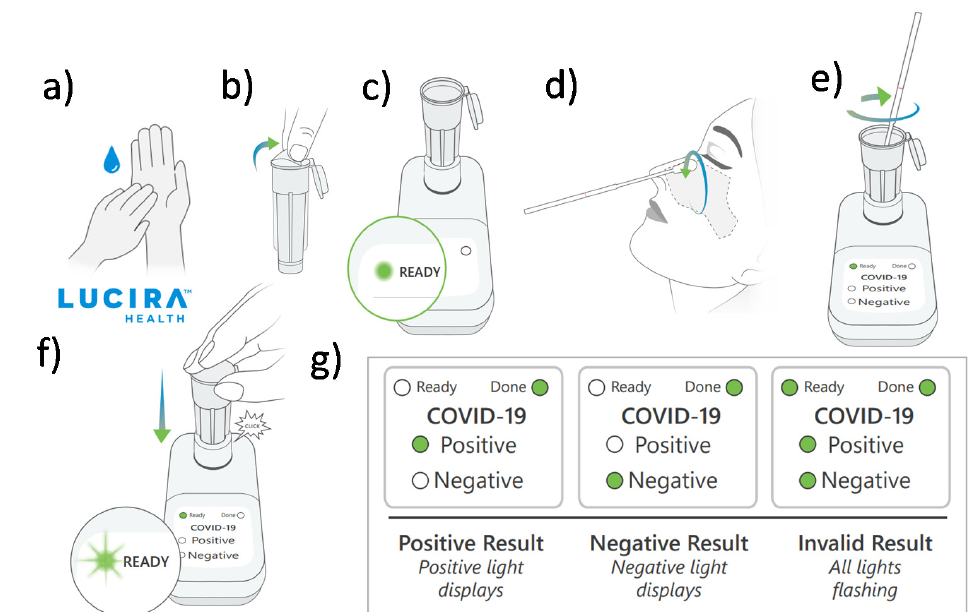
Figure 4. Instructions for using the Lucira COVID-19 All-in-One Test Kit. This involves at-home nasal swab collection followed by RT-LAMP reaction to detect the SARS-CoV-2 genetic material. The steps for use are as follows: ( a ) Wash and dry hands. ( b ) Remove seal from Sample Vial. ( c ) Set the sample vial in the test unit. ( d ) Swab both nostrils. ( e ) Insert swab into the sample vial. ( f ) Snap the cap closed and press the vial into the test unit. ( g ) Wait 30 min and obtain the result. Images are reproduced and adapted with permission from Lucira Health [25].